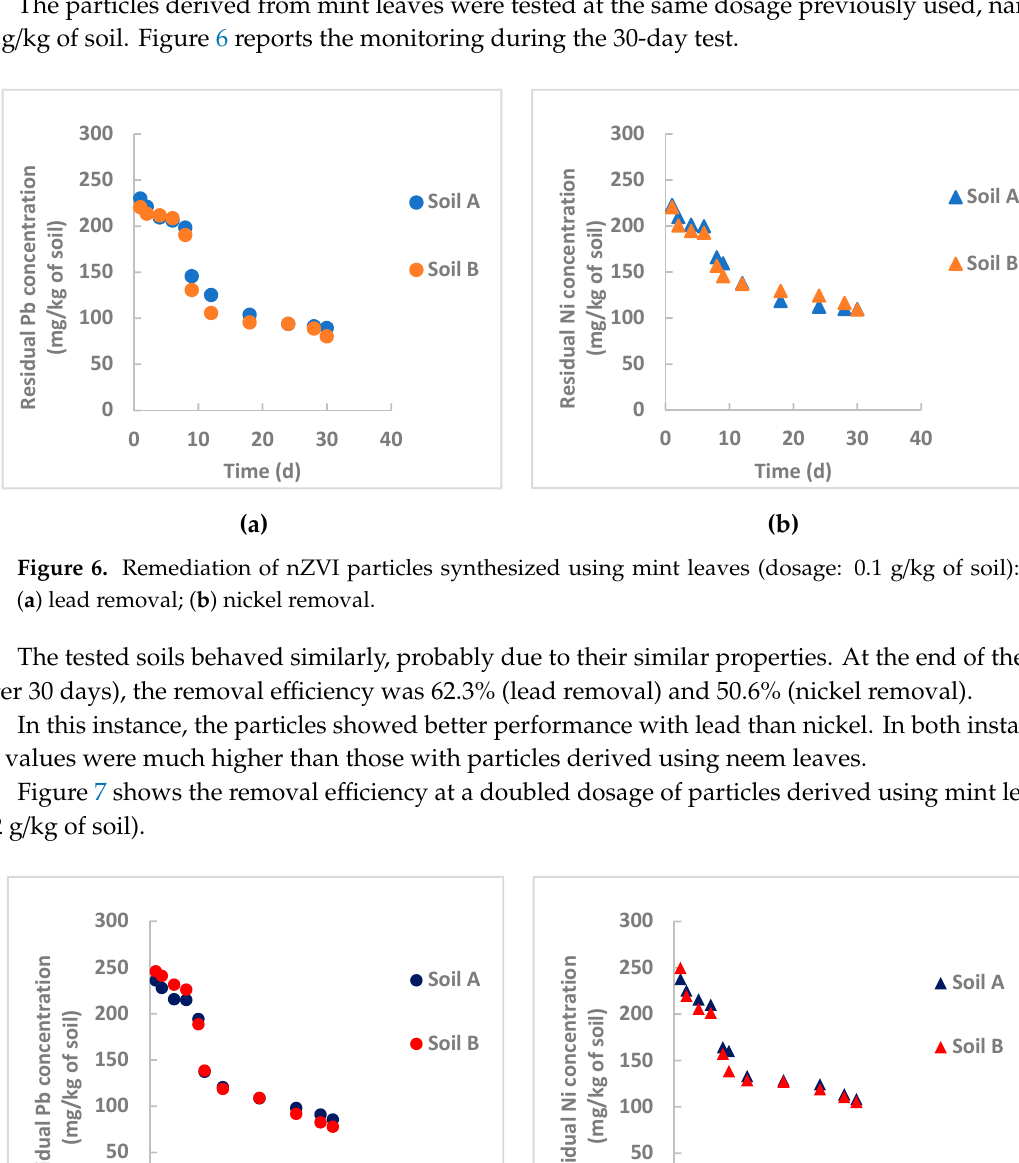
( b ) Figure 5. Remediation of nZVI particles synthesized using neem leaves (dosage: 0.2 g/kg of soil): ( a ) lead removal; ( b ) nickel removal.